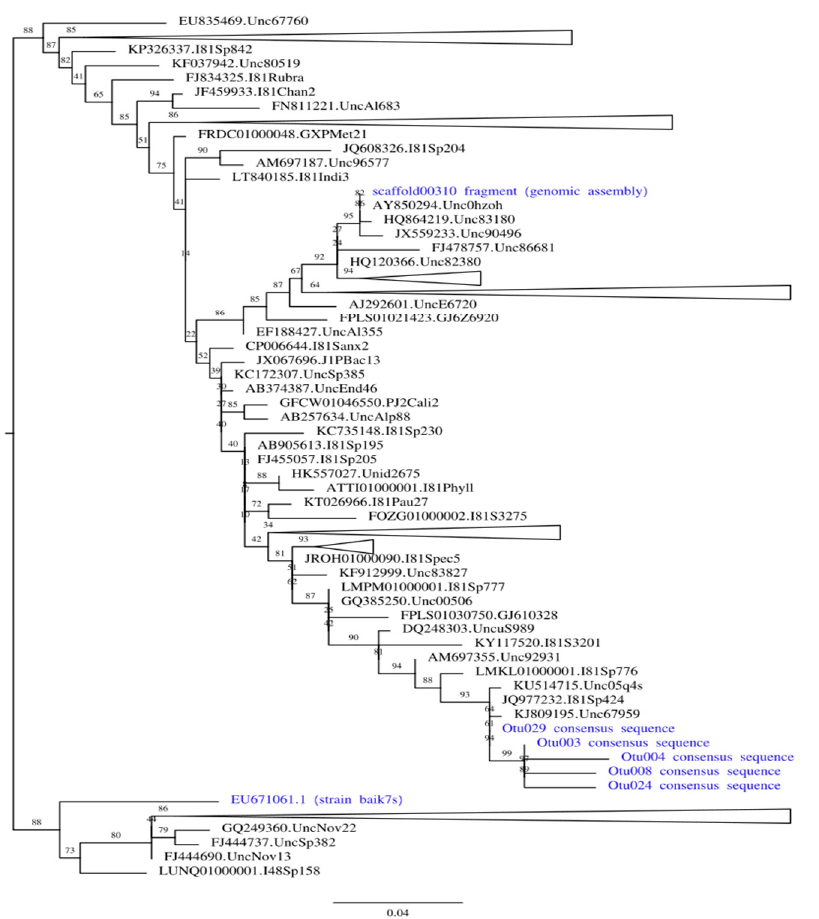
Figure 4. Maximum likelihood phylogenetic tree built on the positions of 16S rRNA alignment limited to amplicon boundaries. All strains associated with F. radians are shown in blue. All clades except those containing our strains of interest are collapsed (the size of collapsed clades is not to scale); complete tree is available in Supplementary Figure S1A.